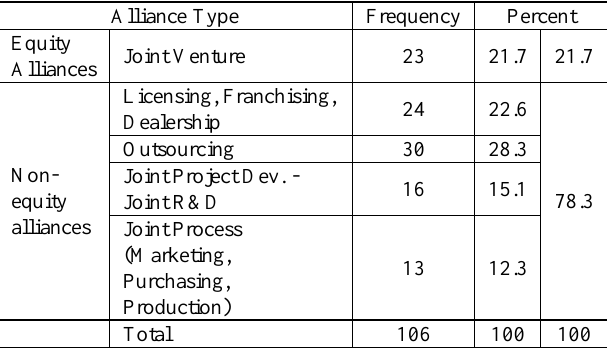
Table 1: Alliance type distribution of the